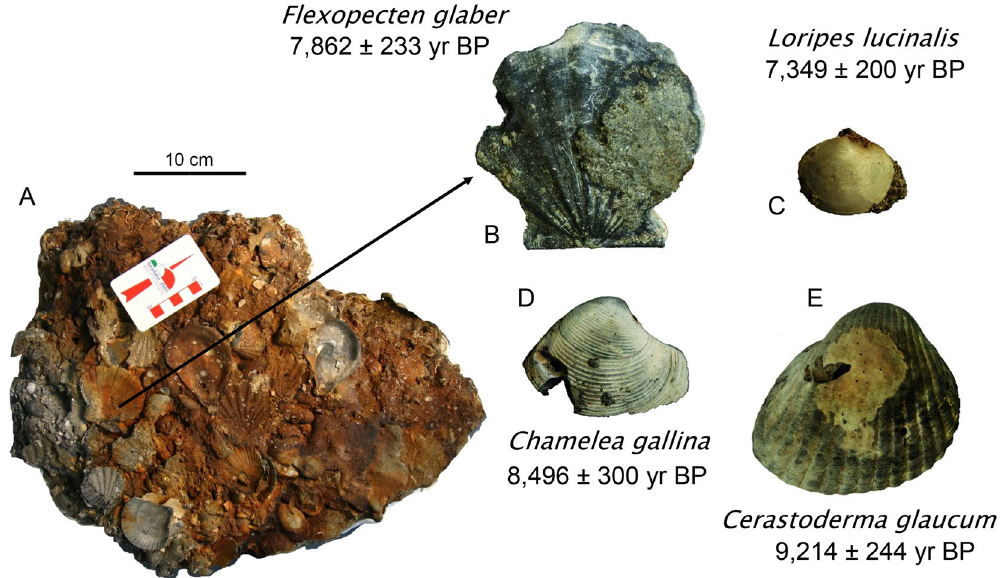
Figure 5. Large mixed siliciclastic carbonate sand slab (MT_01_14) embedding a variety of bioclasts and biosomes from various environments (freshwater, brackish-lagoonal and shallow marine) and AMS- 14 C ages of selected bivalve